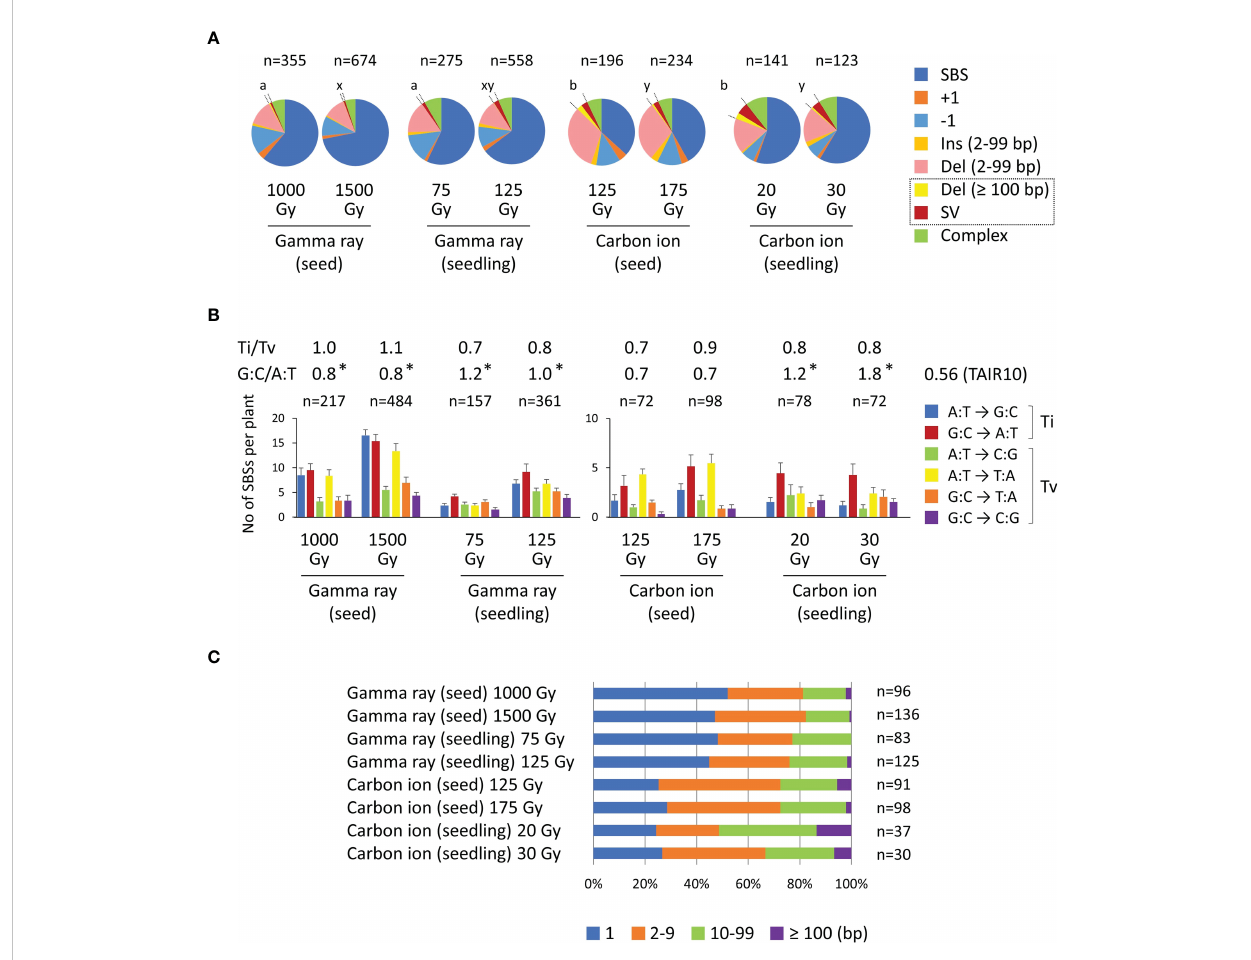
FIGURE 4 Characterization of mutations induced in Arabidopsis dry seeds and 7-day-old seedlings irradiated with 17.3 MeV/u carbon ions or gamma rays. The data in this fi gure include both homozygous and heterozygous mutations. (A) All mutation types detected in each treatment. The proportions of rearrangements (Deletion ≥ 100 bp and structural variation [SV]) are indicated by dotted lines. Statistical comparisons of the proportions of rearrangements were performed at the equivalent dose on survival reduction. Different lowercase letters indicate a signi fi cant difference (a and b are for a comparison at dose 1 (~50% of D q ); x and y are for a comparison at dose 2 (~75% of D q ); Fisher ’ s exact test with multiple comparison correction, p < 0.05). (B) Spectra of single-base substitutions. Complementary substitutions (e.g., G:C to A:T and C:G to T:A) were merged. The T i / T v ratio represents the ratio of total transition to transversion events. The G:C/A:T ratio represents the ratio of G:C pairs to A:T pairs in the original nucleotides that underwent substitutions. Asterisks indicate signi fi cant differences from the A:T/G:C ratio (0.56) of the TAIR10 reference sequence (Fisher ’ s exact test, p < 0.05). (C) Distribution of deletion